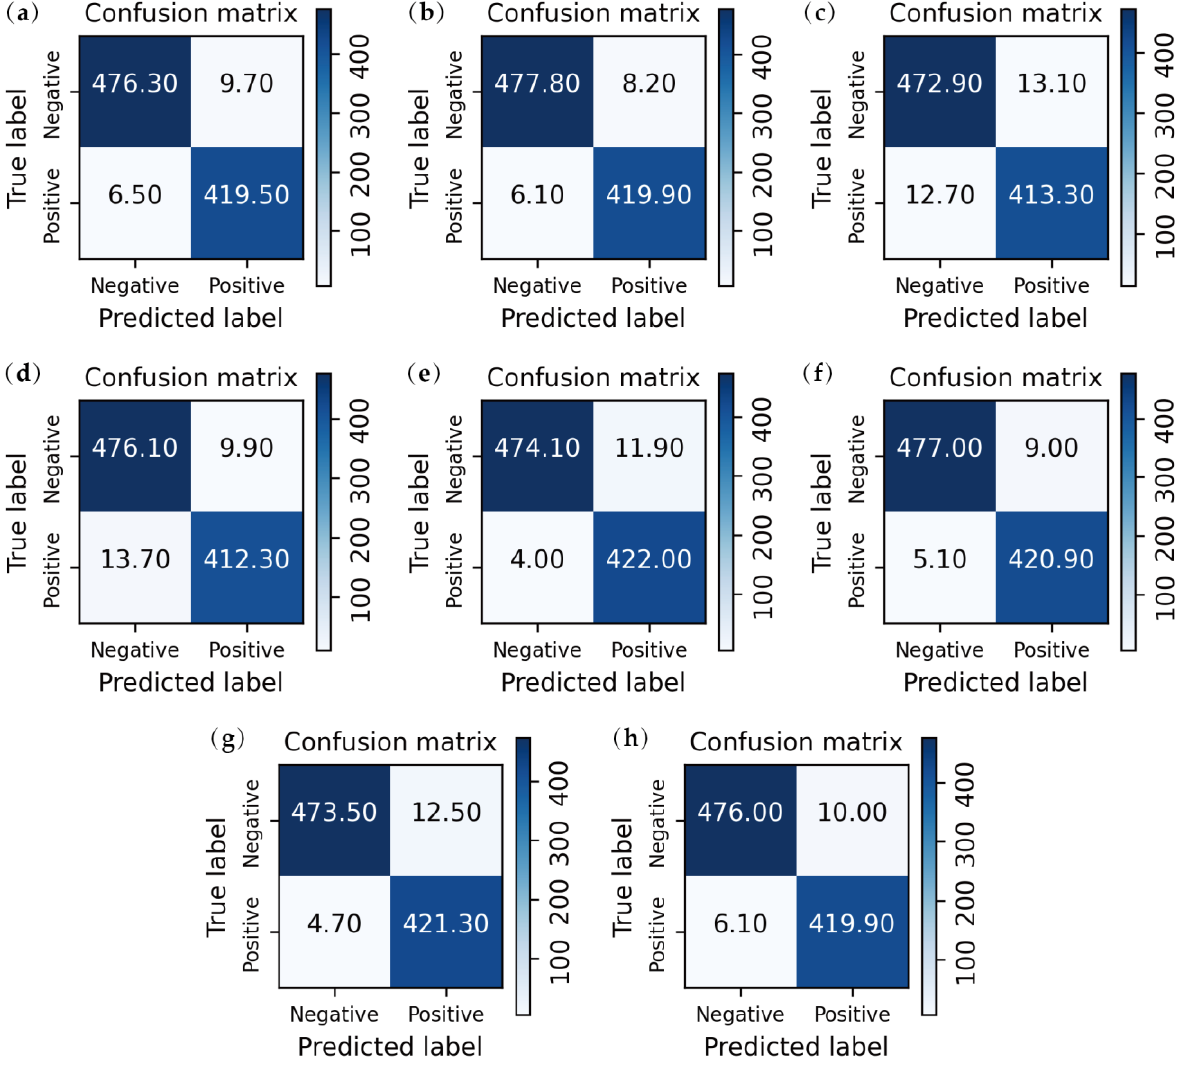
Figure 10. Average confusion matrices for models 9–16 in Table 5. Sub-figures ( a – h ) provide the corresponding visualizations for each model.